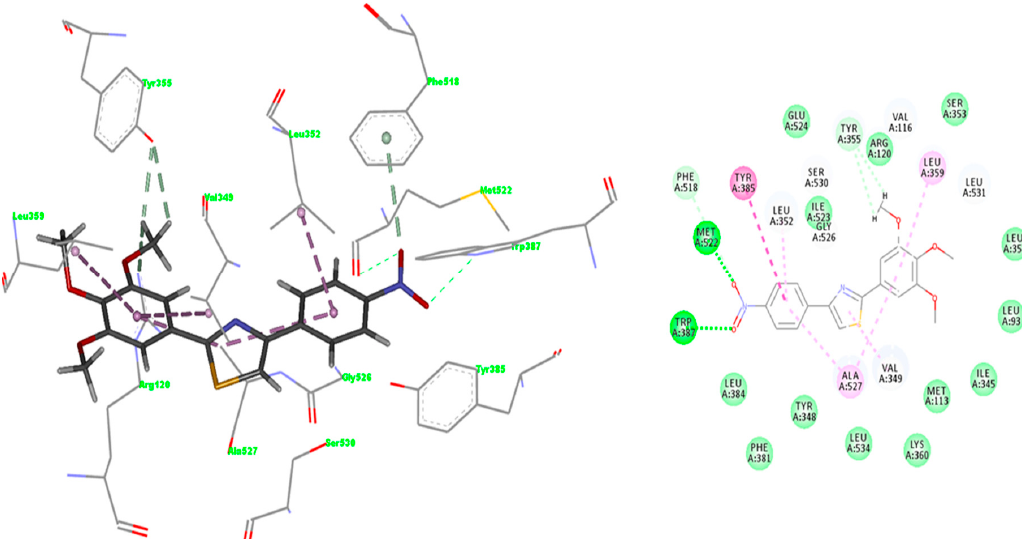
Figure 9. IFD predicted binding mode of compound A3 in COX-1 (PDBID: 4O1Z); H–bonds are depicted in green lines Trp387 (2.867 Å), Met522 (3.184 Å), whereas hydrophobic interactions are shown in purple [28].